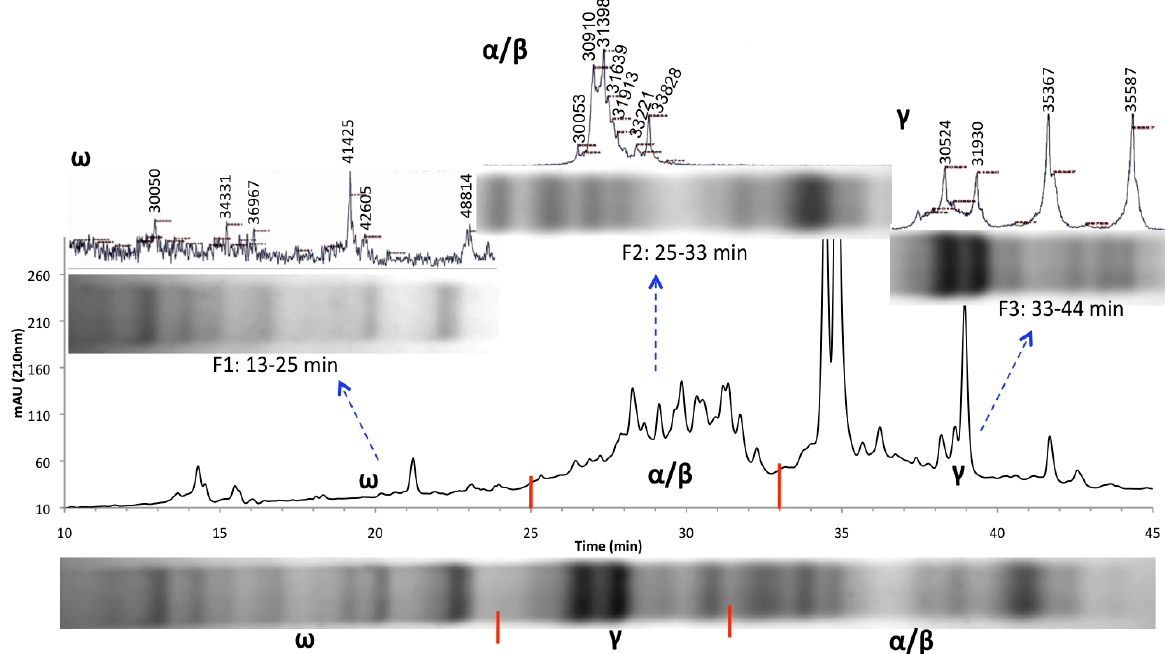
Figure 1. Mass spectra and electrophoresis patterns of the Brundage 96 gliadin extract, representing analysis of the bulk sample ( bottom ) and separate analysis of three HPLC fractions collected at 13–25, 25–33 and 33–44 min ( top ). Samples were resolved on acid-PAGE gels, as well as by MALDI-TOF-MS. F =